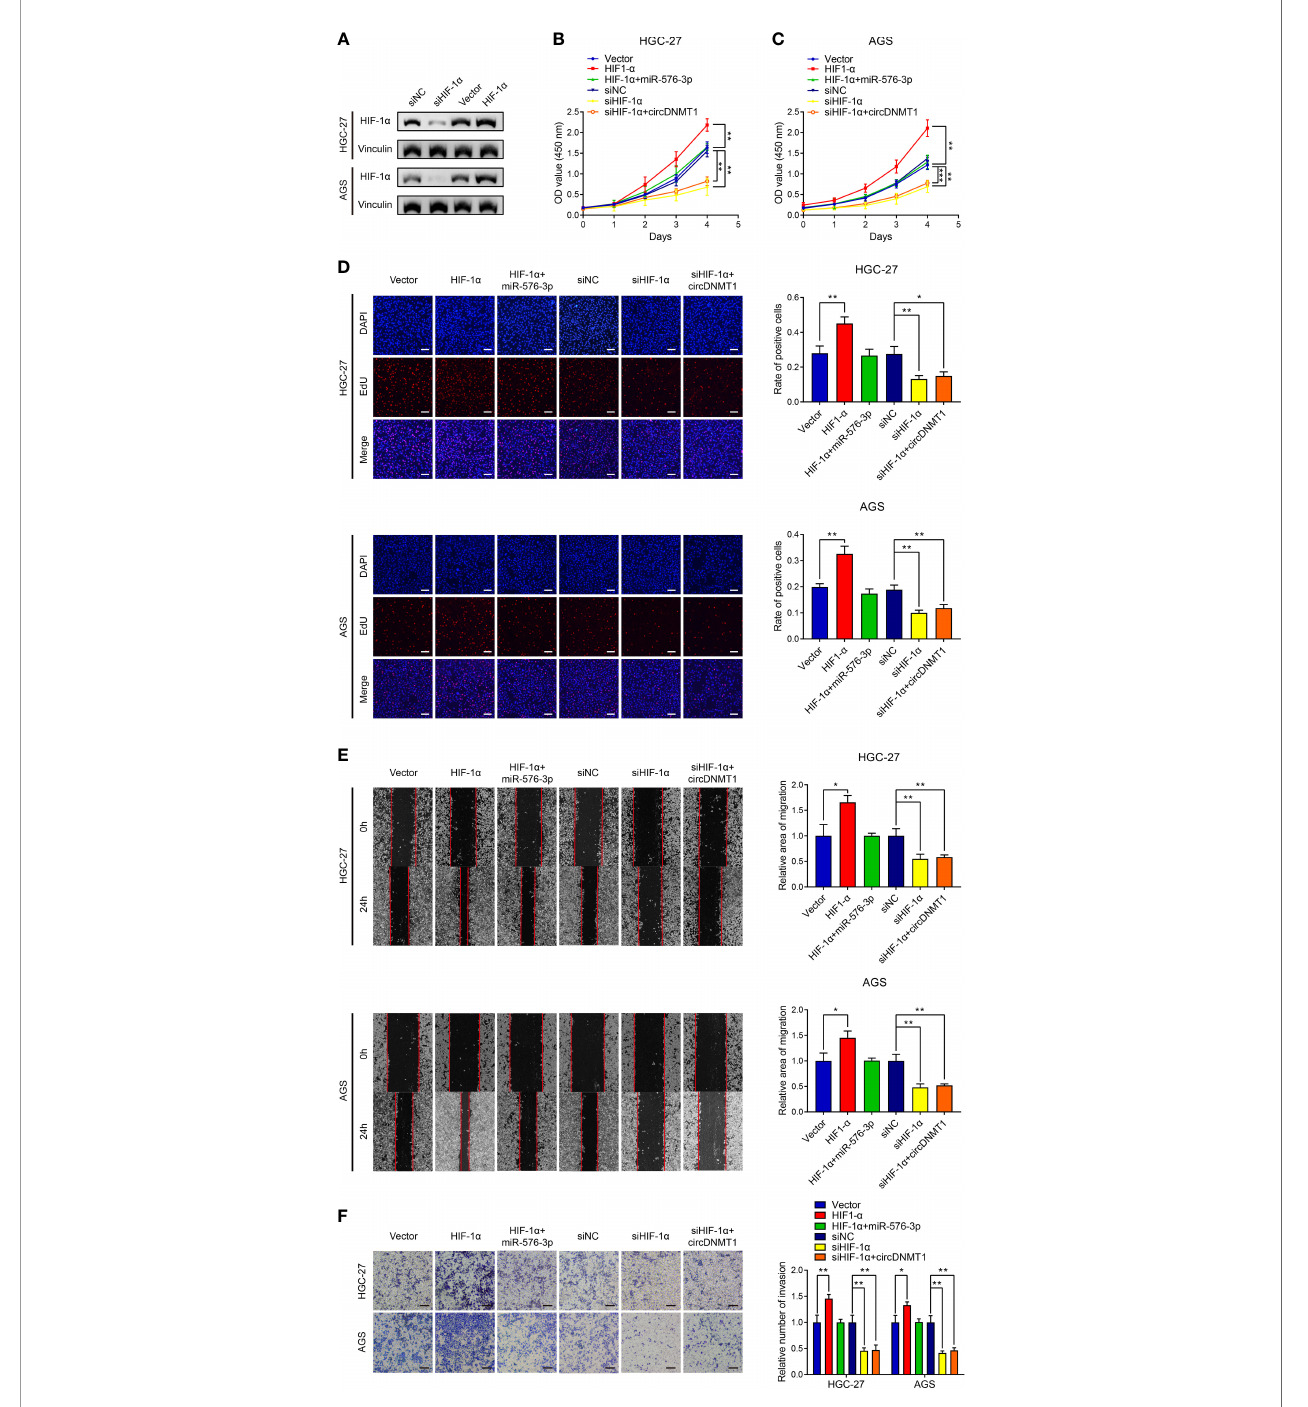
FIGURE 6 | circDNMT1 promotes GC malignancy by targeting miR-576-3p/HIF-1 a axis. (A) The WB analysis to show HIF-1 a expression in HGC-27 and AGS cells transfected with NC shRNA or HIF-1 a siRNA, or carrying lentivirus with vector or HIF-1 a overexpression plasmids. (B, C) The CCK-8 assay to show proliferation of HGC-27 (B) and AGS (C) cells. They could be divided into two groups: i) The cells stably carrying lentivirus with vector or HIF-1 a overexpression plasmids and transfected with NC or miR-576-3p mimics; ii) The cells transfected with NC shRNA or HIF-1 a siRNA and carrying lentivirus with vector or circDNMT1 overexpression plasmids. (D) The EdU assay to show proliferation of cells as in (B, C) . Scale bar: 100 m m. The histogram is displayed on the right. (E) The wound healing assay to show migration of cells as in (B, C) . The histogram is displayed on the right. (F) The transwell assay to show invasion of cells as in (B, C) . The histogram is displayed on the right. Scale bar: 100 m m. Data were presented as means ± SD. *P < 0.05, **P < 0.01, ***P <